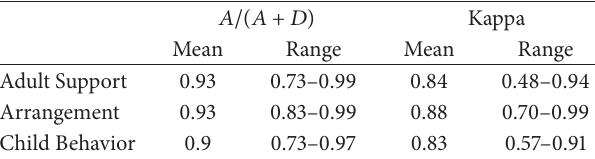
Table 2: Interobserver